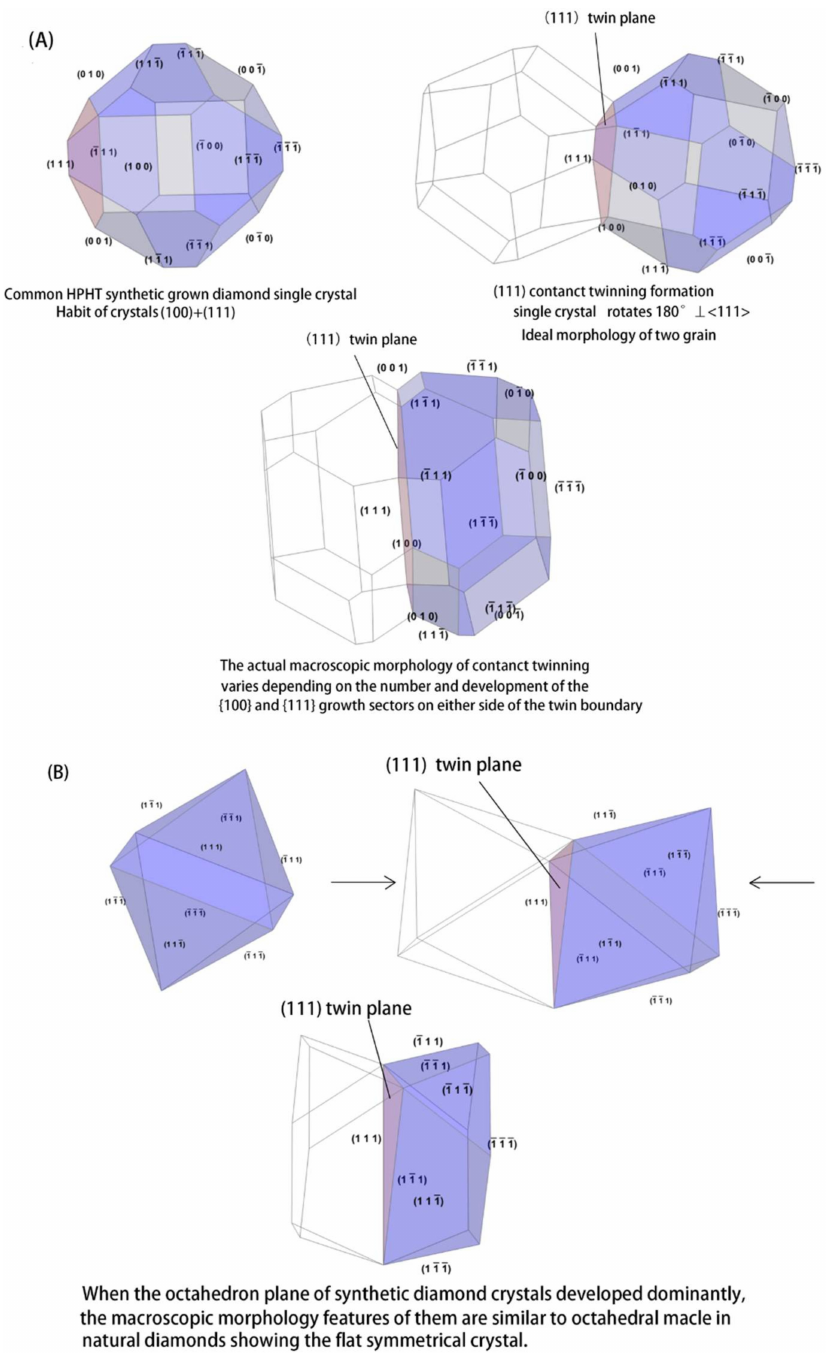
Figure 8. Twin models of HPHT synthetically grown diamond with contact twinning: ( A ) The common crystal morphology of HPHT synthetically grown diamond is cubic-octahedral. When the contact twinning forms, the single crystal rotates 180 ◦ along the <111> axis and the twin plane is (111); ( B ) When the octahedron plane of the HPHT synthetically grown diamond crystals were developed, The macroscopic morphology feature of contact twinning shows similar features to Macle in natural